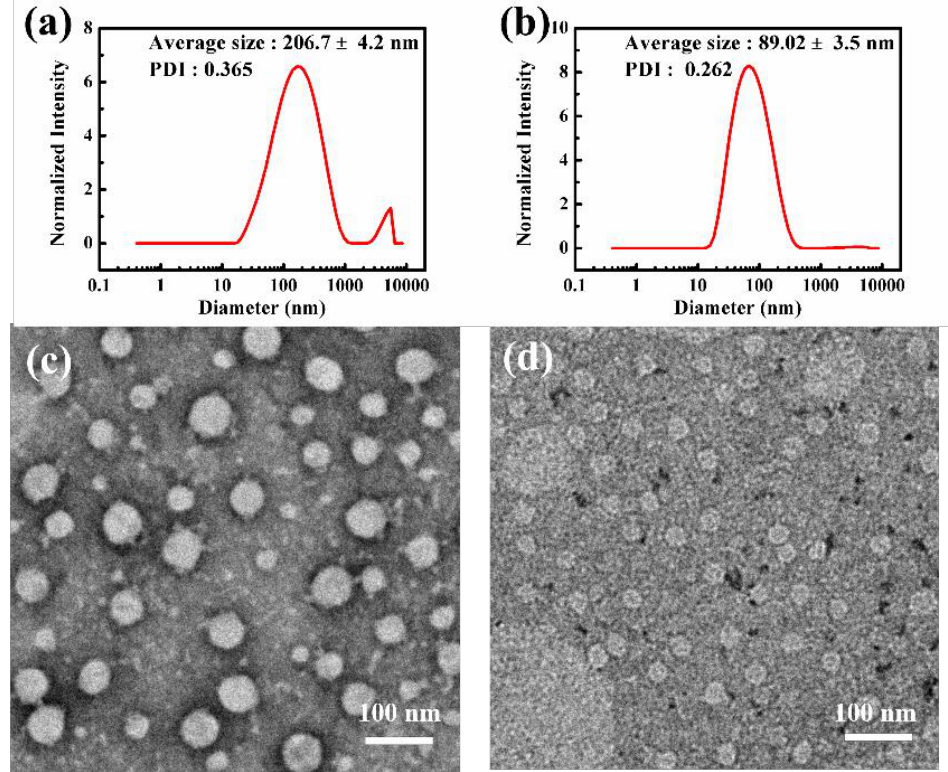
Figure 4. Size distributions of P 1 ( a ), and P 2 ( b ) micelles in water; TEM images of P 1 ( c ), and P 2 ( d ) micelles in water at a polymer concentration of 0.5 mg/mL (scale bar: 100 nm).